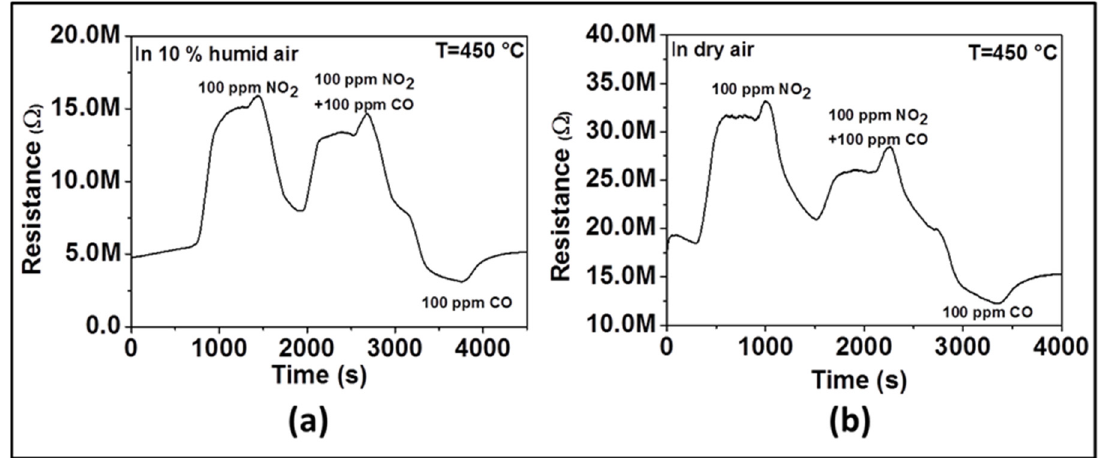
Figure 8. Dynamic response of ZnO thin film to 100 ppm NO 2 , 100 ppm NO 2 + 100 ppm CO, and 100 ppm CO at 450 °C in humid air ( a ) and dry air ( b ).